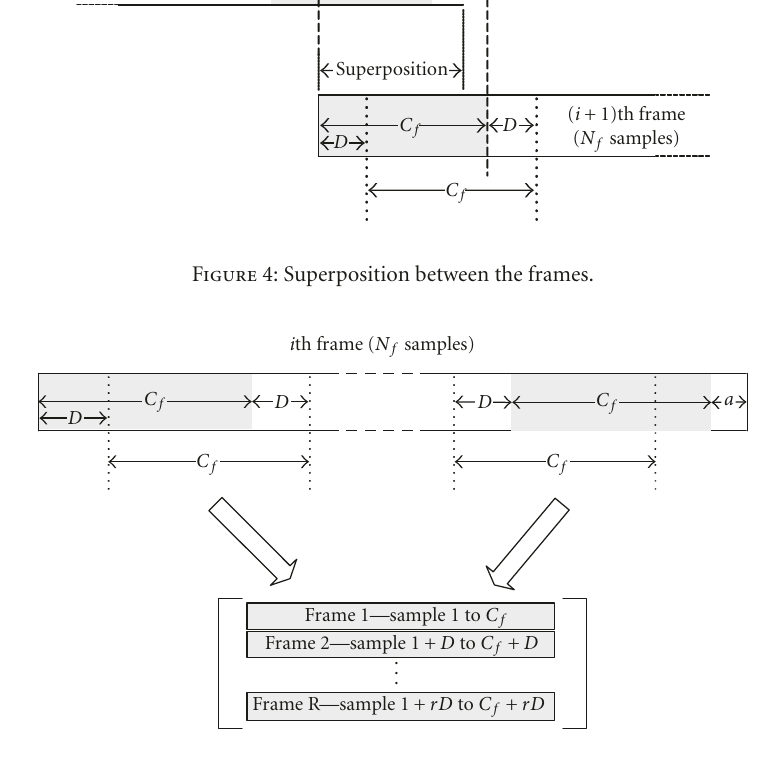
Figure 5: Concatenation of subframes into a